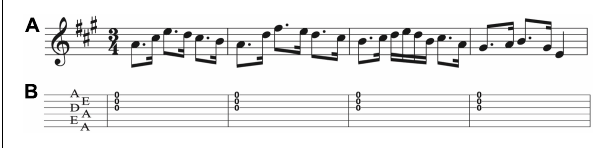
FIGURE 3 | Melody (A) and available guitar strings (B)